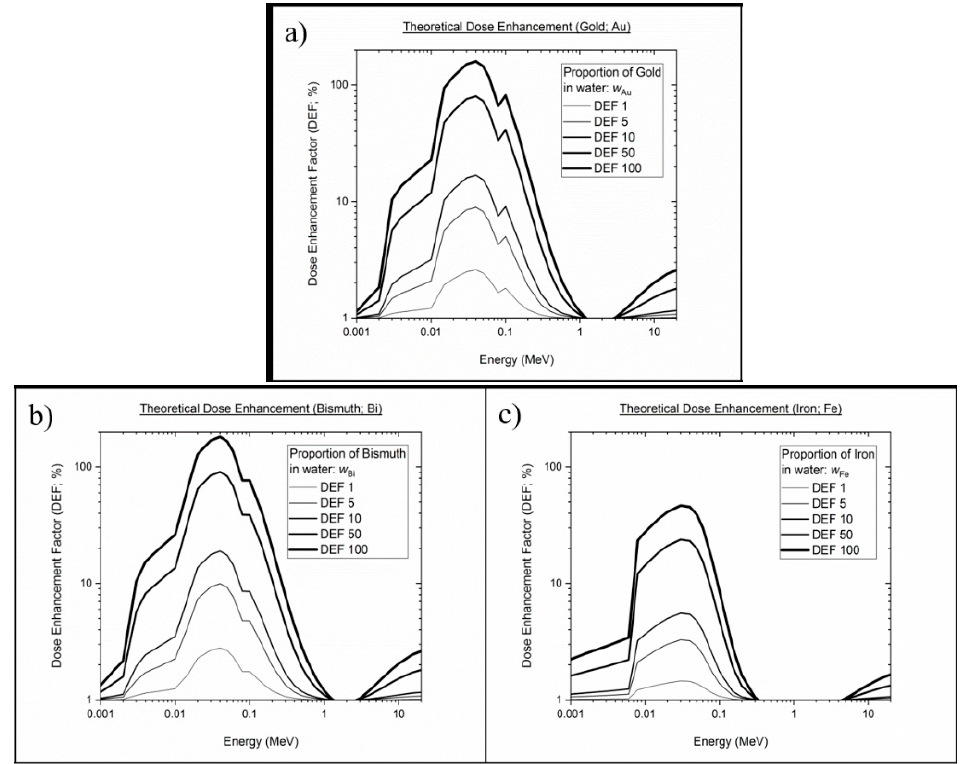
Figure 5. Theoretical dose enhancement factor of core of the metallic elements at various energy ranges and concentration percentages in water: ( a ) Gold, ( b ) Bismuth, ( c ) Iron.